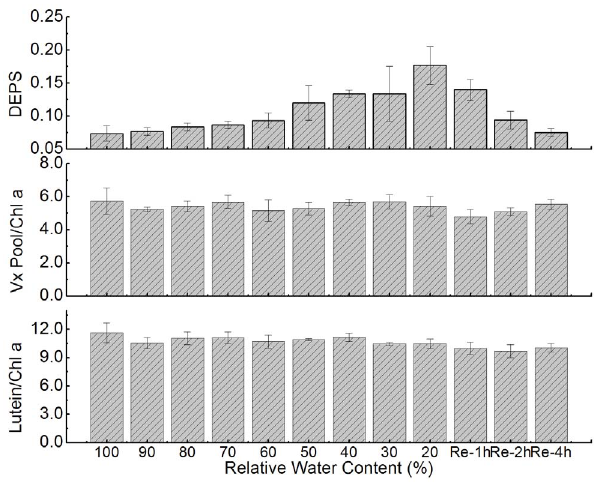
Figure 2. Effects of varying levels of desiccation on the xanthophyll cycle and lutein content of U.pertusa thalli. Thalli of U. pertusa were emersed in air under dim light (0.7 m mol m –2 s –1 ) for desiccation treatment and then rehydrated in seawater for 1, 2 and 4 hours. The xanthophyll cycle was activated by desiccation as indicated by the increase in the de-epoxidation state (DEPS) value, which is calculated as (Ax + Zx)/(Vx + Ax + Zx). The relative content of the Vx pool (Vx + Ax + Zx) and lutein is presented as m g per mg of chlorophyll a; this also applies to Figs. 3, 5 and 6. Error bars represent SD for n=3.